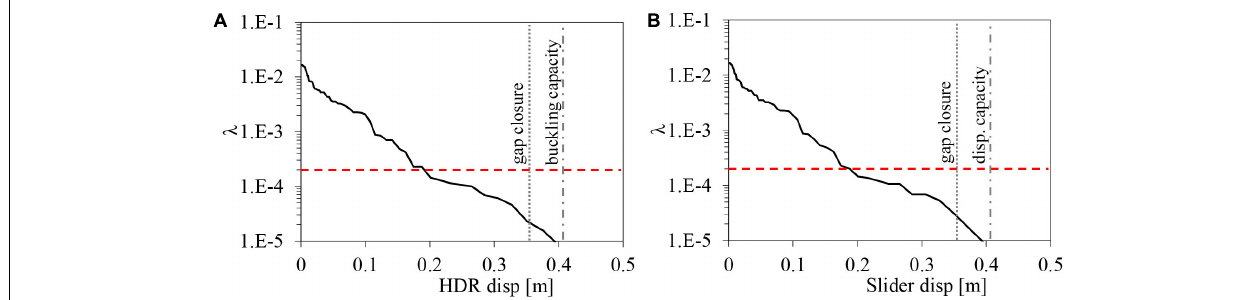
FIGURE 11 | Hazard curve of the maximum displacement of HDR bearings (A) and sliders (B) .